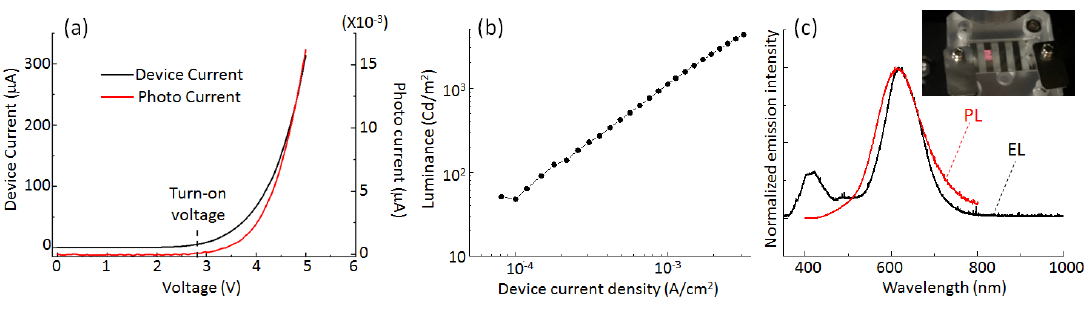
Figure 3. ( a ) Device I − V characteristics (black line) and photodiode I − V characteristics (red line), ( b ) luminance − current density characteristics, and ( c ) a typical electroluminescence (EL) spectrum at the operation voltage of 5 V (PL spectrum of the corresponding SiQD-De dispersed in chloroform). A photograph demonstrates a representative pale-orange-light-emitting quantum dot light emitting diode